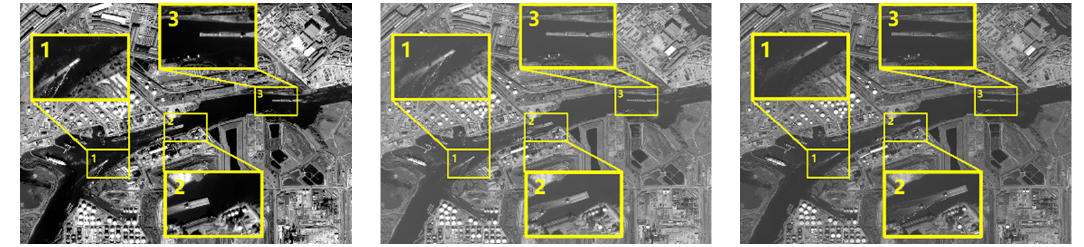
Figure 4. Original multi-view sequence images. Table 1. Interval time and base-height ratio of sequence images.